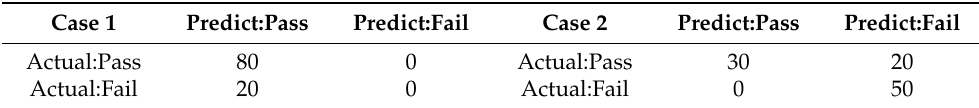
Table 1. An example showing the limitation of CA and CC